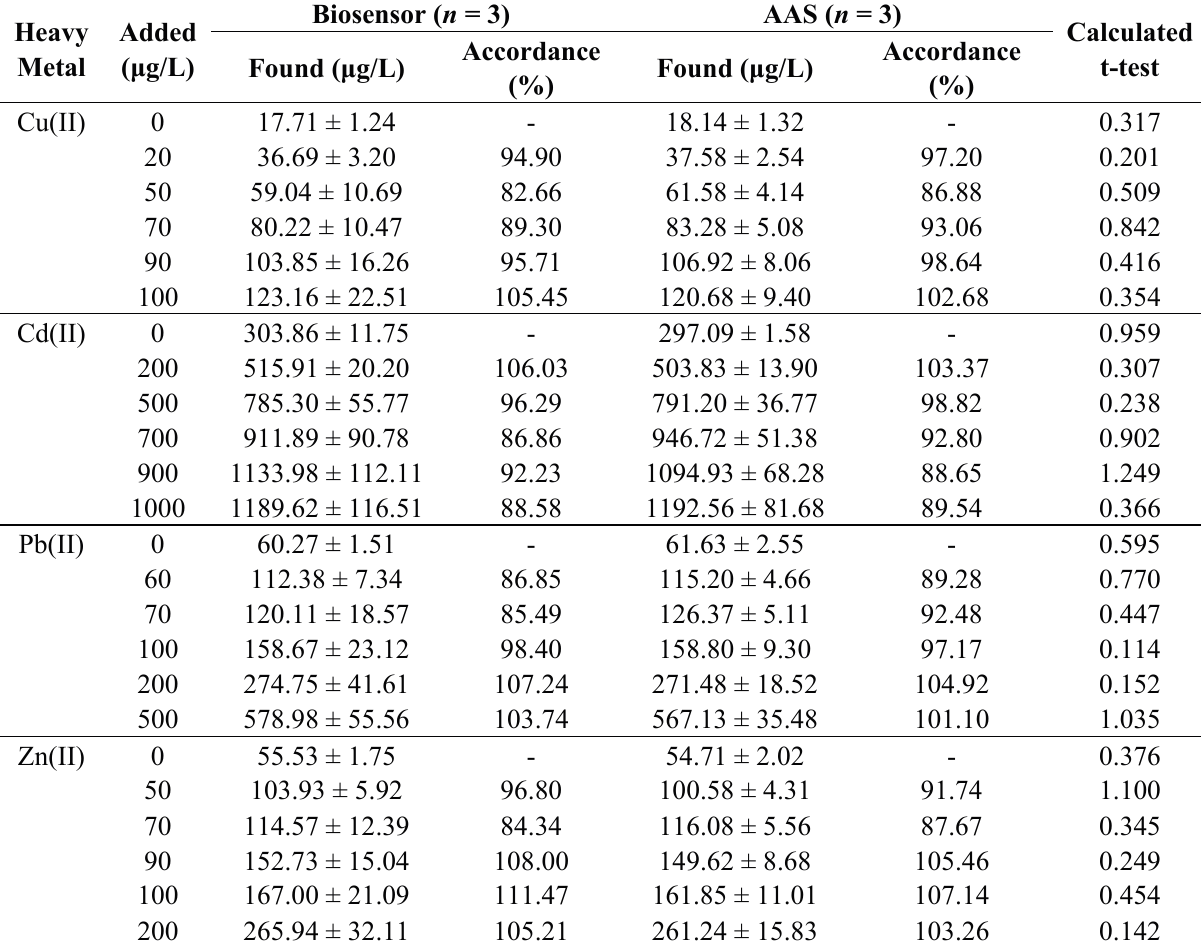
Table 6. Accordance of Cu(II), Cd(II), Pb(II) and Zn(II) ions spiked in Langat River water samples by both developed A. fischeri -based biosensor and AAS method.